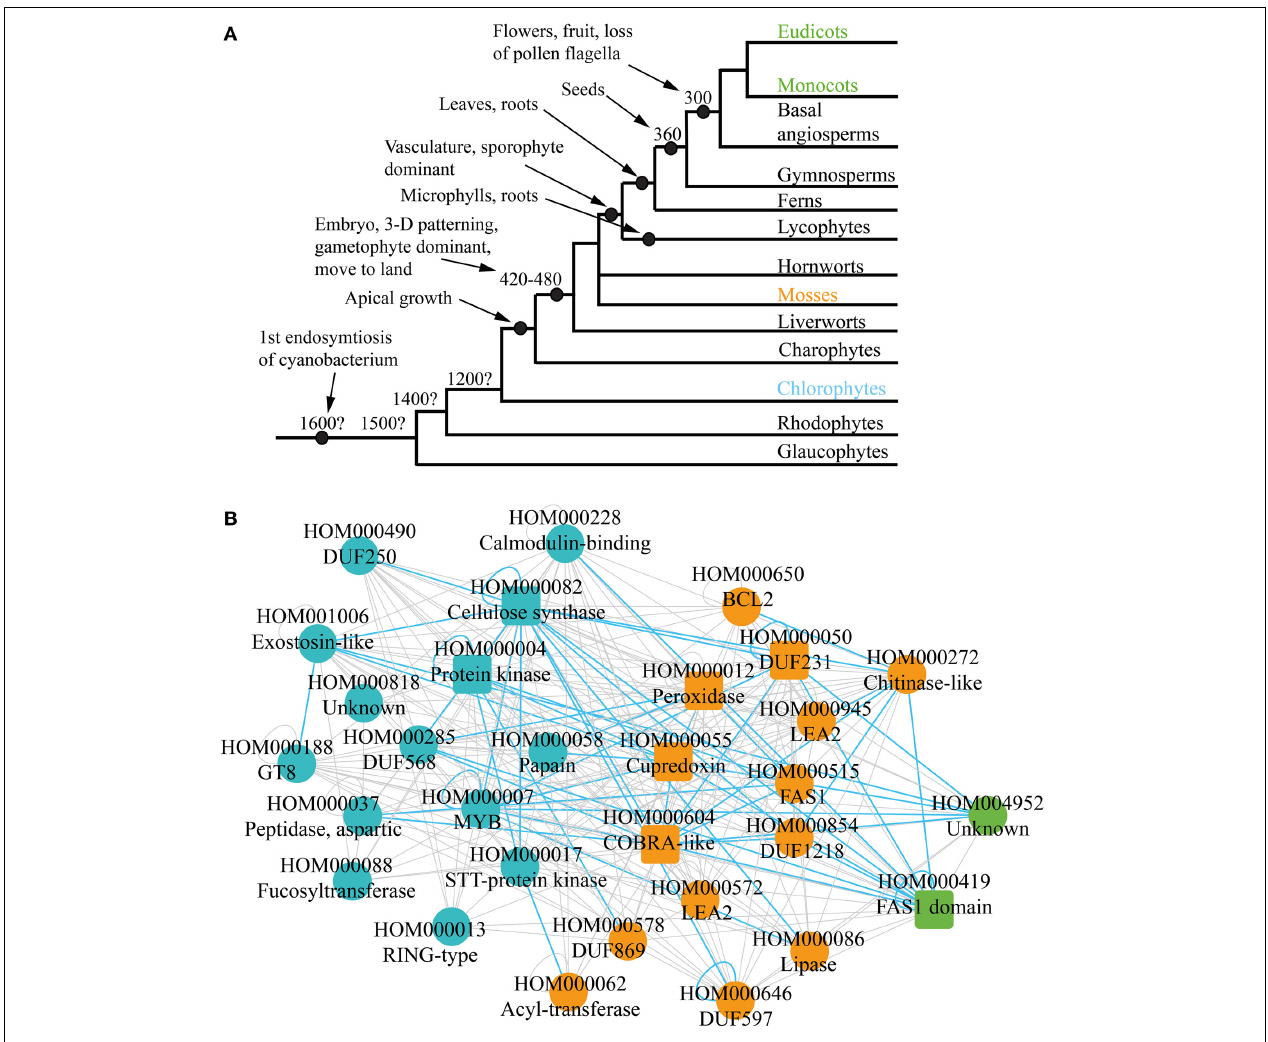
FIGURE 3 | Phylogenetic analysis of the co-expression networks. (A) Depicted are relationships among the lineages of plants. Estimated dates for some nodes are shown in millions of years before the present date. Major events are demarcated by black nodes and arrows. (B) Gene family